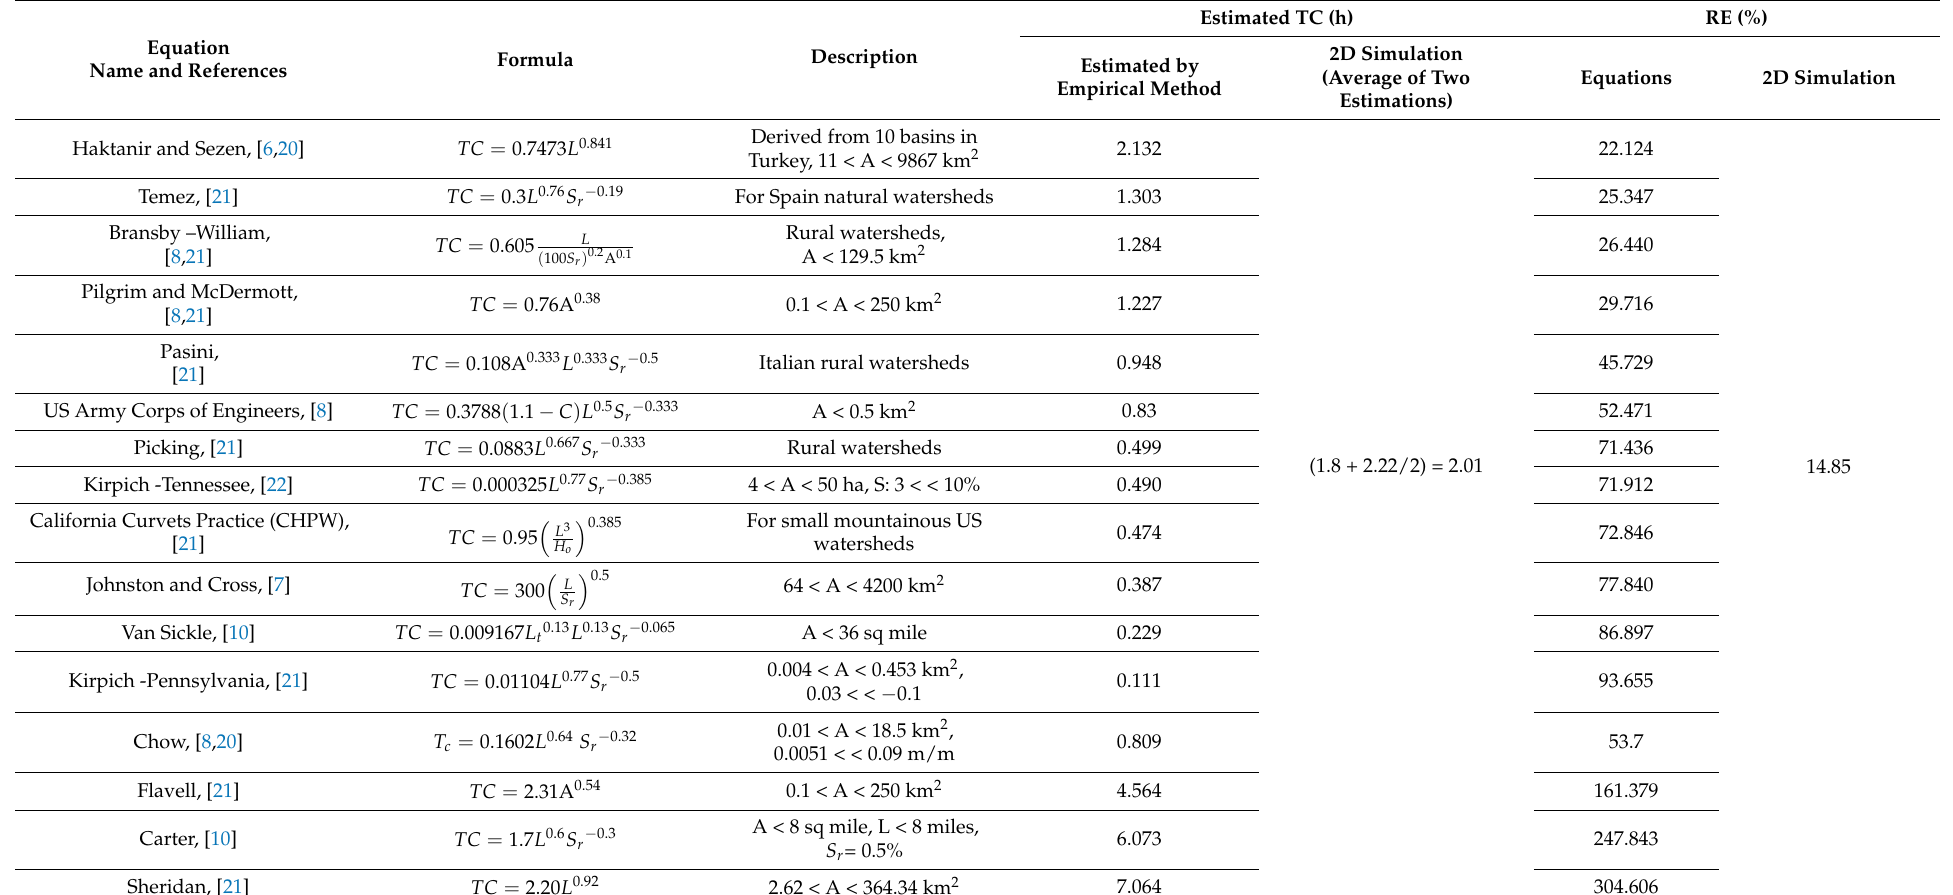
Table 2. TC (h) and RE (%) for methods based on L , L t , S r , and A (category